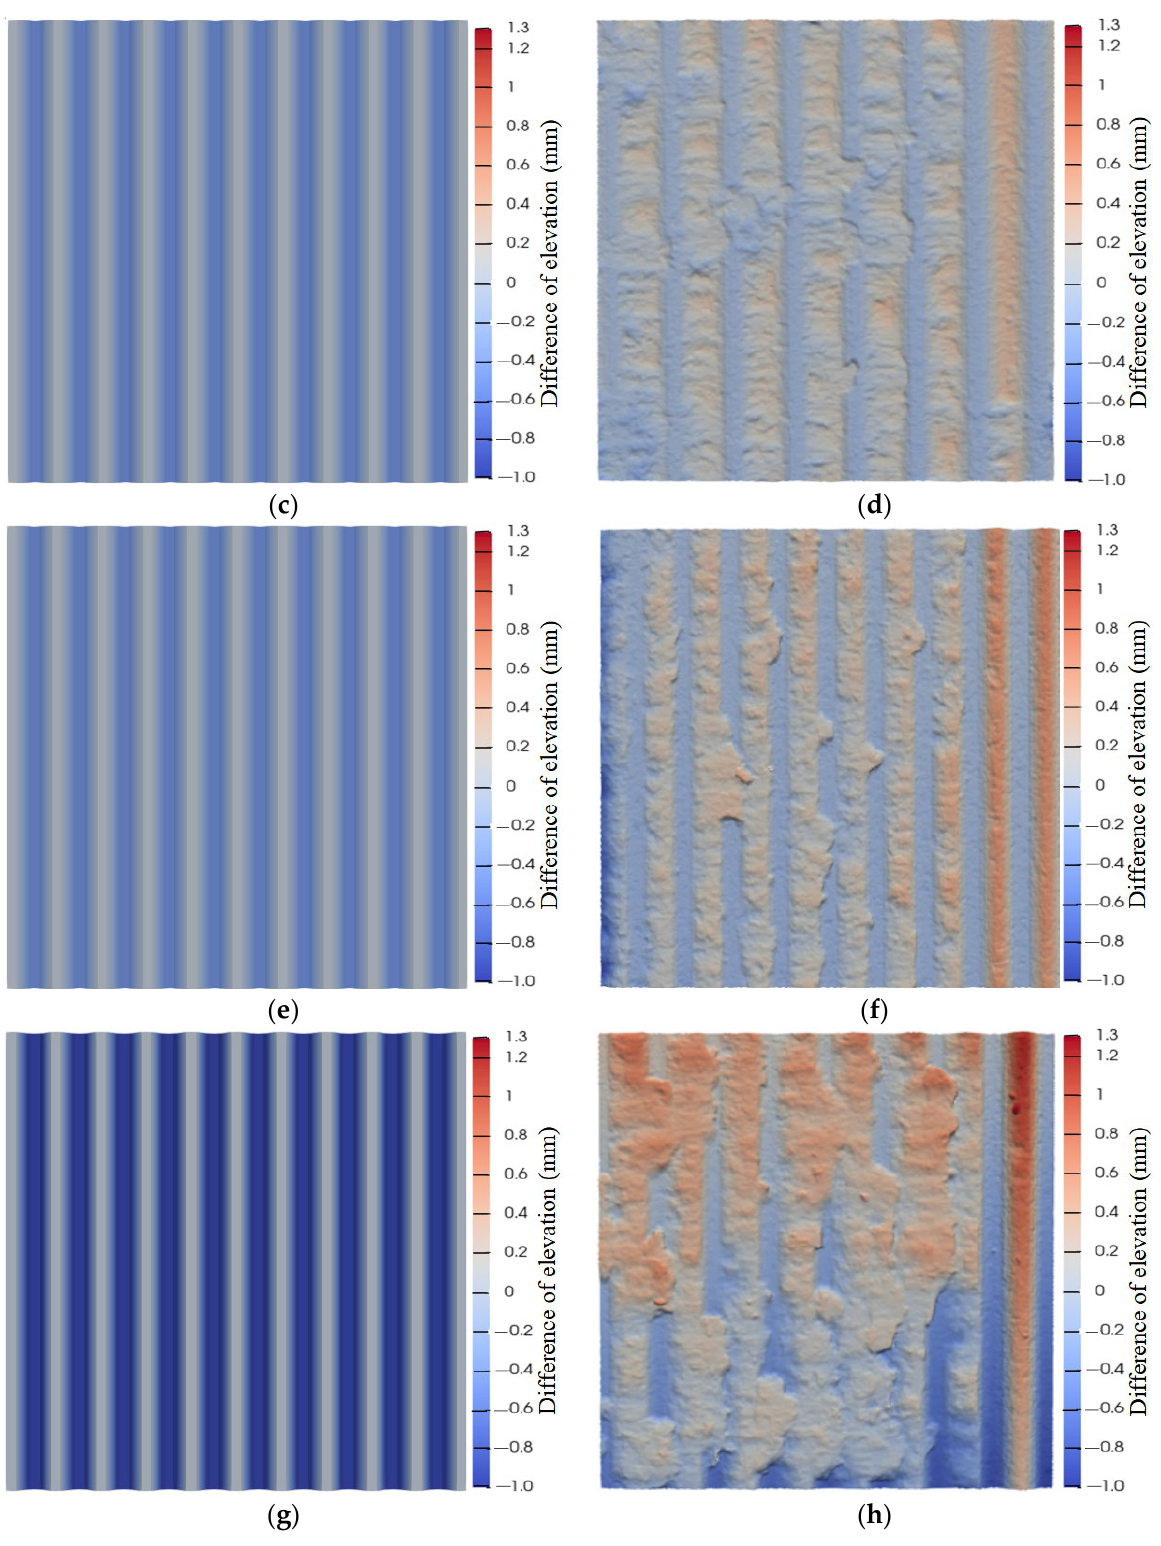
Figure 15. Comparison of structural plane before and after a direct shear test with different undulating angles. ( a ) Sample 10-2 before test; ( b ) Sample 10-2 after test; ( c ) Sample 20-2 before test; ( d ) Sample 20-2 after test; ( e ) Sample 30-2 before test; ( f ) Sample 30-2 after test; ( g ) Sample 40-2 before test; ( h ) Sample 40-2 after test.